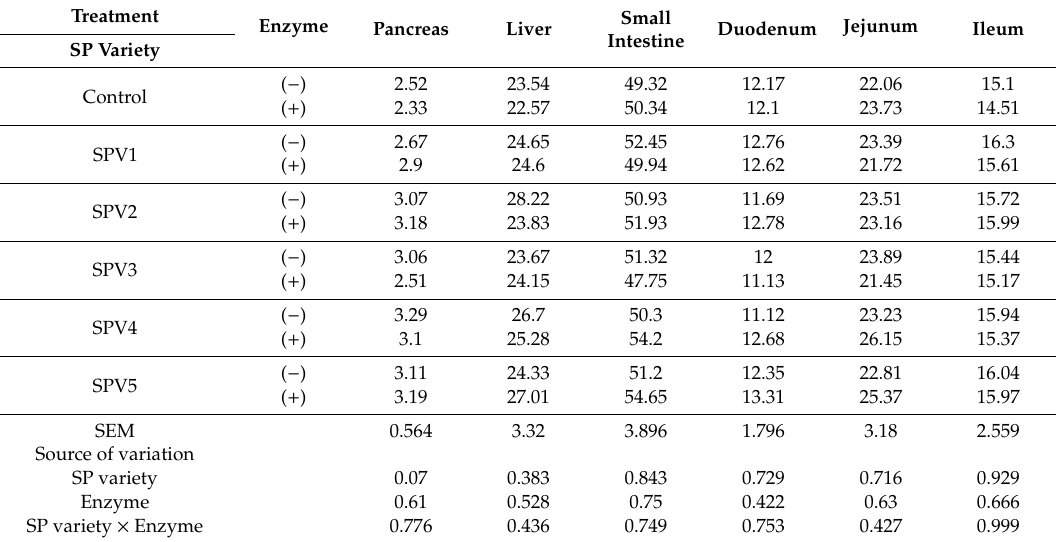
Table 8. Dietary e ff ects on the relative organ and intestinal segments (g / kg) of